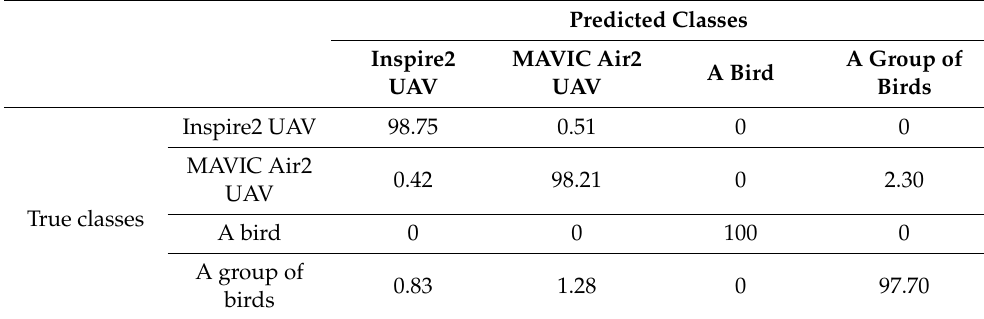
Table 5. Confusion matrix (%) of the ‘Proposed’.